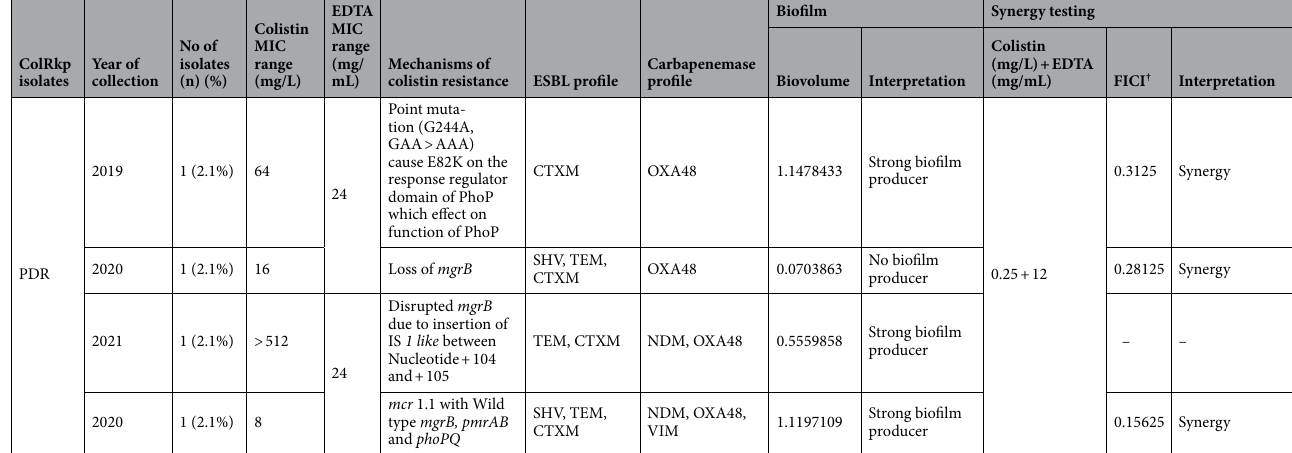
Table 2. Mechanisms of colistin resistance with respective MIC, FICI, biofilm biovolume and drug-resistant genes profiles of 47 ColRkp clinical